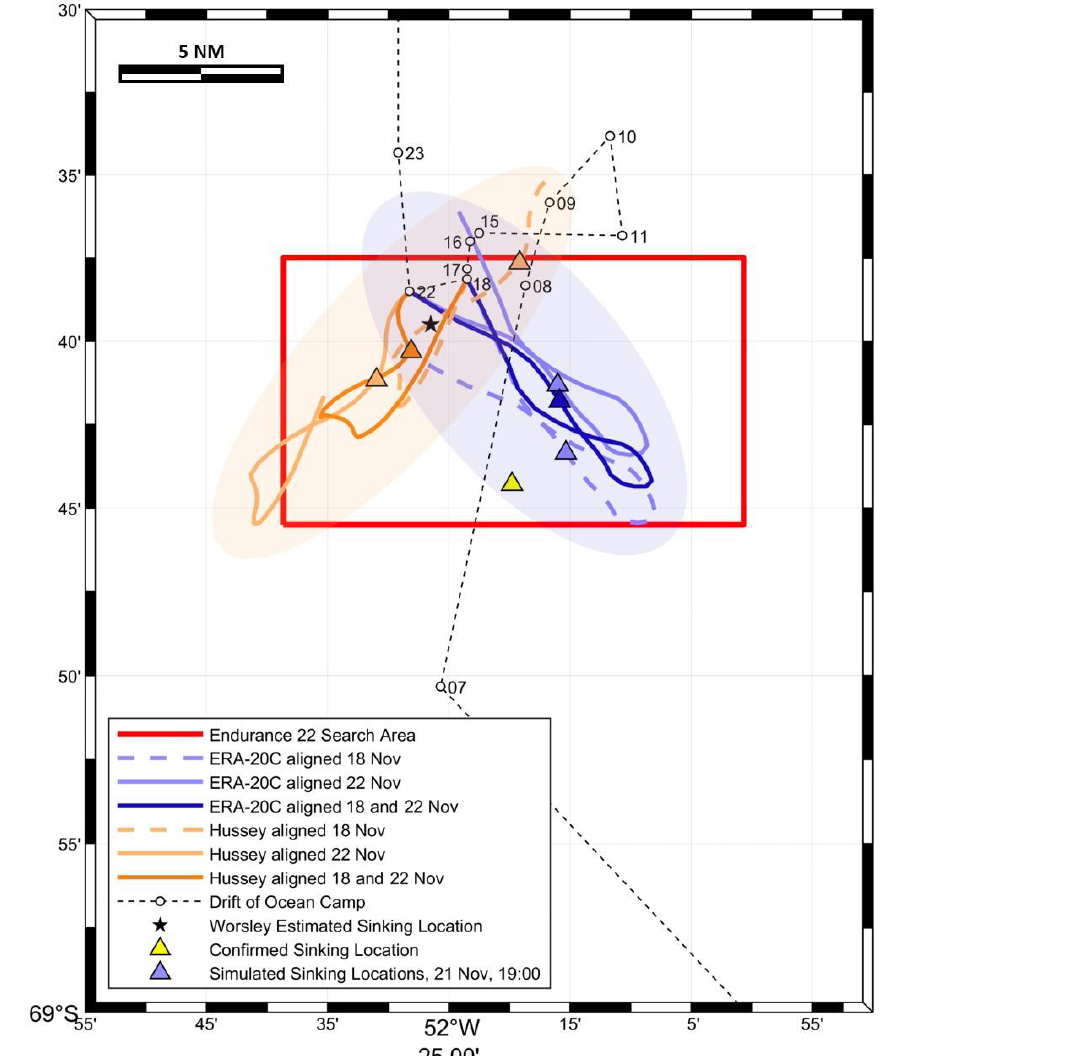
Figure 2. Case 1 reconstructed drift tracks and sinking sites using ERA-20C reanalysis (blue) and Hussy’s meteorological observations (orange). Case 1 utilised a wind factor of 1.75% and a turning angle of 0 ◦ . Coloured ellipses show approximate uncertainty regions associated with the respective